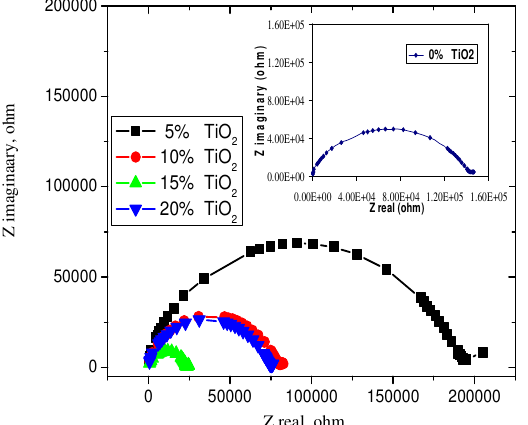
Figur 2. Variation of imaginary ( Z ″ ) with real ( Z ′ ) part of impedance of PEG–NH % of TiO with different concentrations ( x ) of TiO 2 The typical Nyquist plot of the samples comprises of a broadened semicircle in the high frequency region followed by a tail (spike) in the lower frequency region (in some plots).